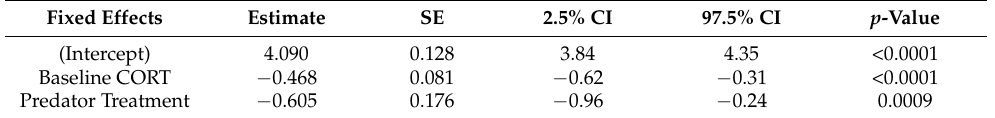
Table 2. Mixed effects model output. Intercept reference categories are agitation CORT and no predator treatment. We found a significant effect of both CORT type ( p < 0.0001) and treatment ( p = 0.0009).